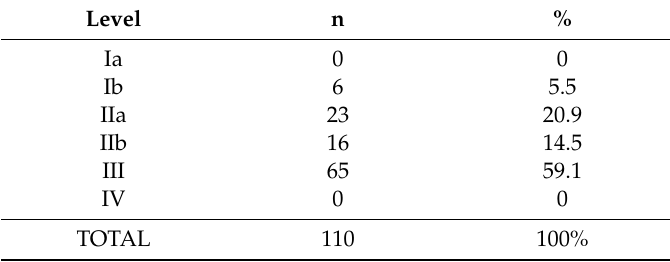
Table 1. Classification of articles according to the level of evidence (Agency for Healthcare Research and